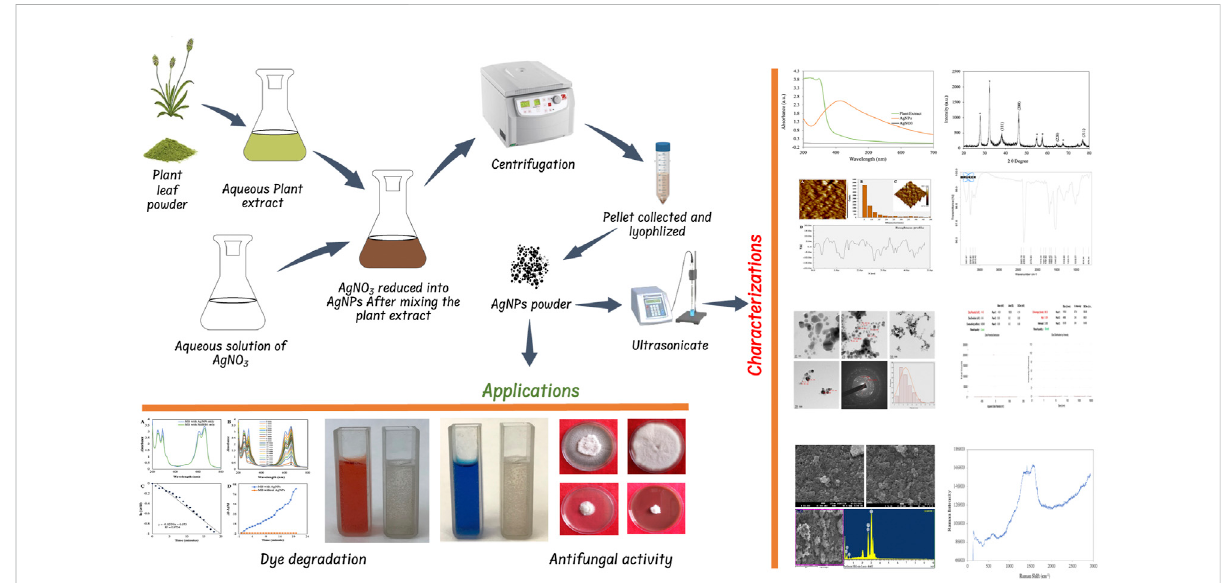
FIGURE 1 Schematic illustration of the synthesis of AgNPs and their characterization and